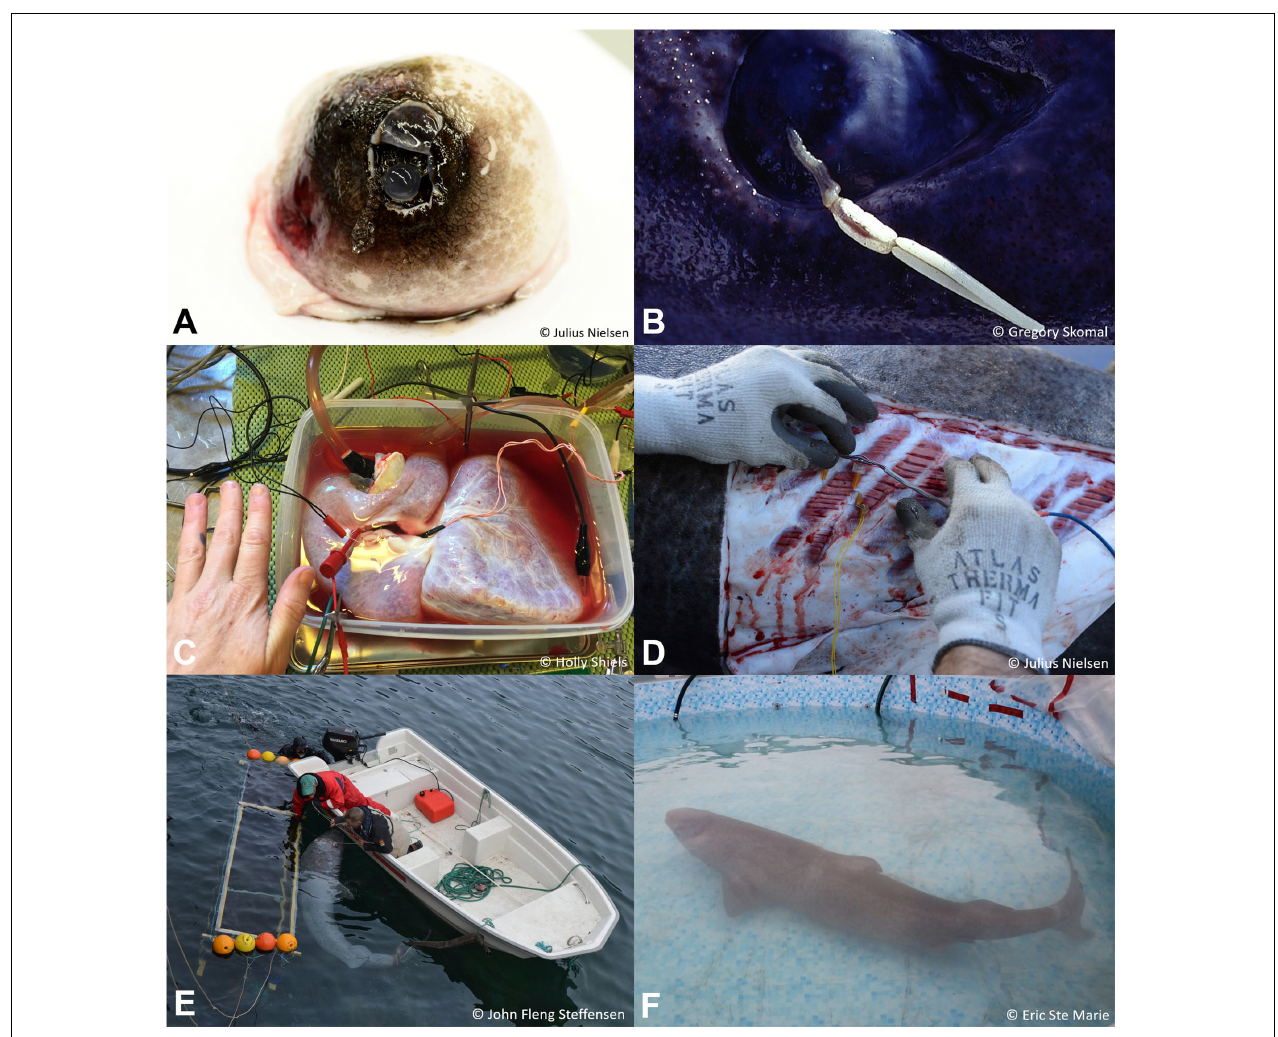
FIGURE 4 | Examples of Greenland shark physiological studies: (A) Eye with exposed cornea (photo © Julius Nielsen, used with permission). (B) Eye with parasitic copepod ( O. elongata ; photo © Gregory Skomal, used with permission). (C) Attachment of electrodes to heart (photo © Holly Shiels, used with permission). (D) Attachment of electrodes to the musculature (photo © Julius Nielsen, used with permission). (E) Shark and respirometry tank setup (photo © John Fleng Steffensen, used with permission). (F) Shark in respirometry swimming pool setup (photo © Eric Ste Marie, used with